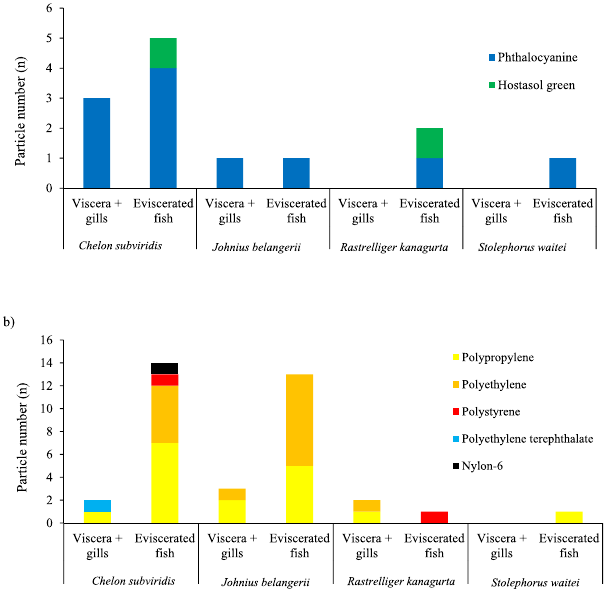
Figure 6. Stacked bar chart of the isolated particles from the excised organs or the eviscerated flesh. ( a ) The prevalence (n) of plastic polymer and ( b ) pigment particles; n =